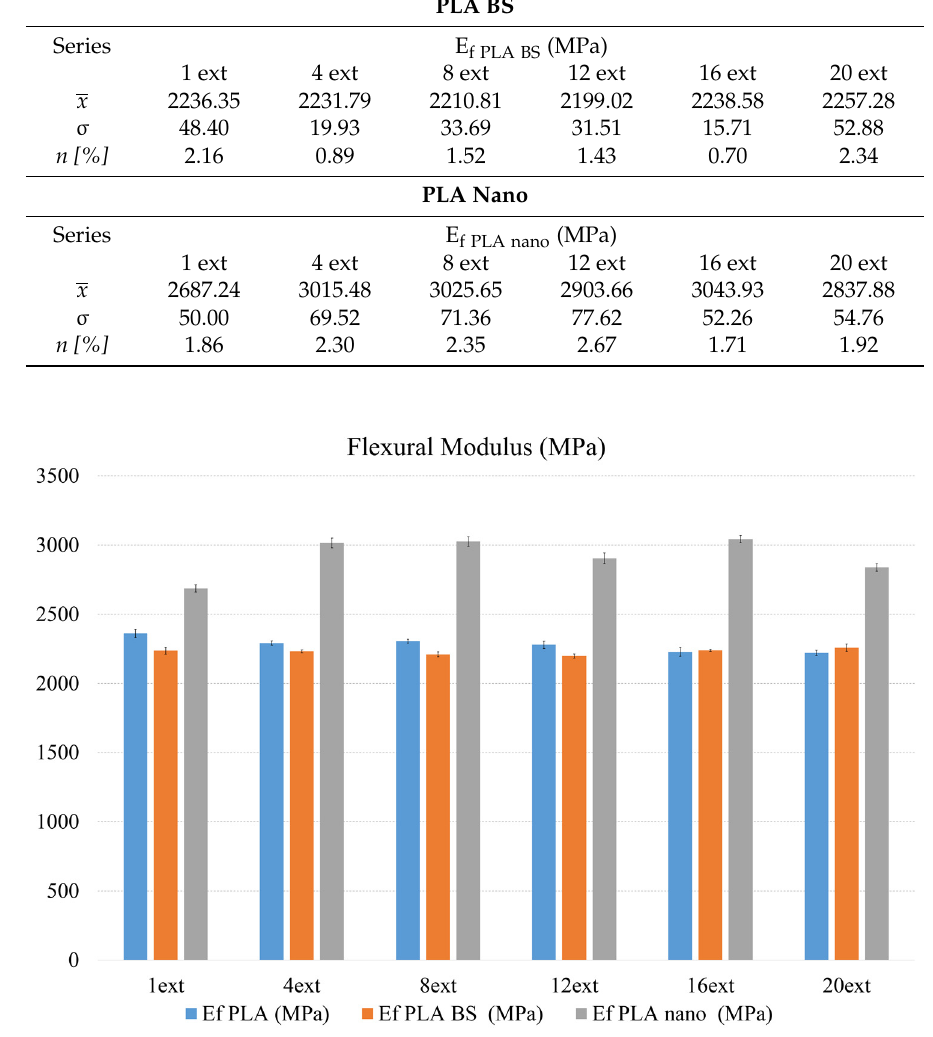
Figure 1. Flexural Modulus of the three formulations by each extrusion.